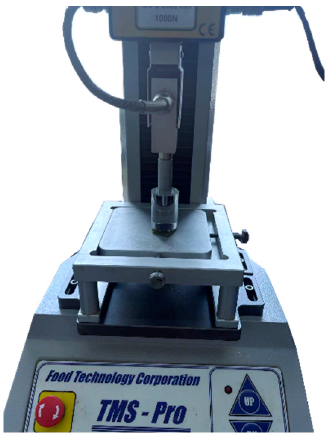
Figure 6. Schematic diagram of compression test device.